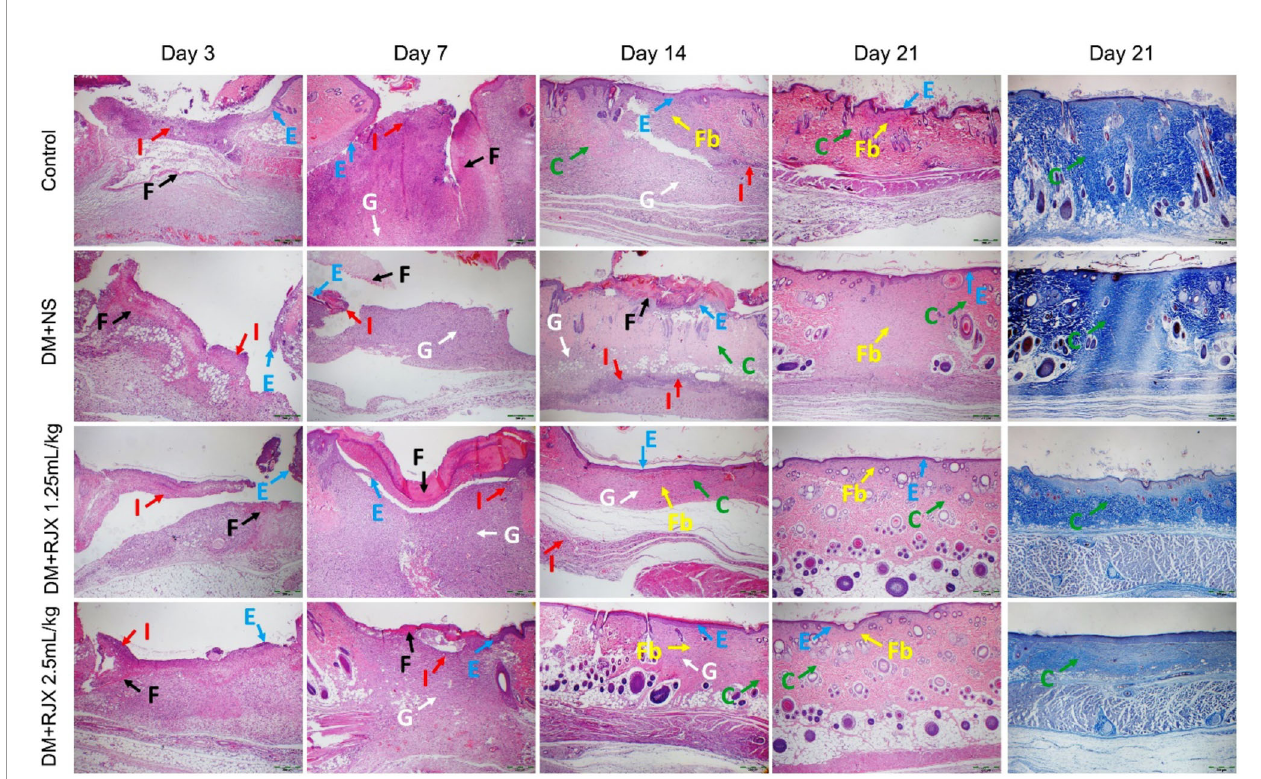
FIGURE 3 | The Effects of Rejuveinix (RJX) on Histological Changes in Diabetic Wound Healing. Groups of 20 Wistar albino rats were treated with i.p injections of RJX (1.25 mL/kg and/or 2.5 mL/kg), or vehicle (NS). Except for untreated control rats (Control), each rat was fed a high-fat diet (HFD) for 4 weeks and injected a single dose of streptozotocin (STZ, 45 mg/kg i.p.) to induced diabetes (DM). At the end of 4 weeks, an experimental wound with a diameter of 5 mm was formed in all rats. On days 3, 7, 14, and 21, fi ve rats in each group were randomly selected. Photomicrographs Demonstrating Rapid Re-epithelialization of Cutaneous Wounds In RJX-Treated Diabetic Rats. Columns 1-4: Blue arrow (E): Re-epithelialization; Red arrow (I): In fl ammation; Black arrow (F): Fibrin, Fibrinogen; White arrow (G): Granulation; Green arrow (C): Collagen; Yellow arrow (Fb): Fibrosis. H&E X40. Column 5: Ampli fi ed Collagen Deposition in Skin Wounds of RJX-treated Diabetic Rats on Day 21. Masson ’ s trichrome staining.